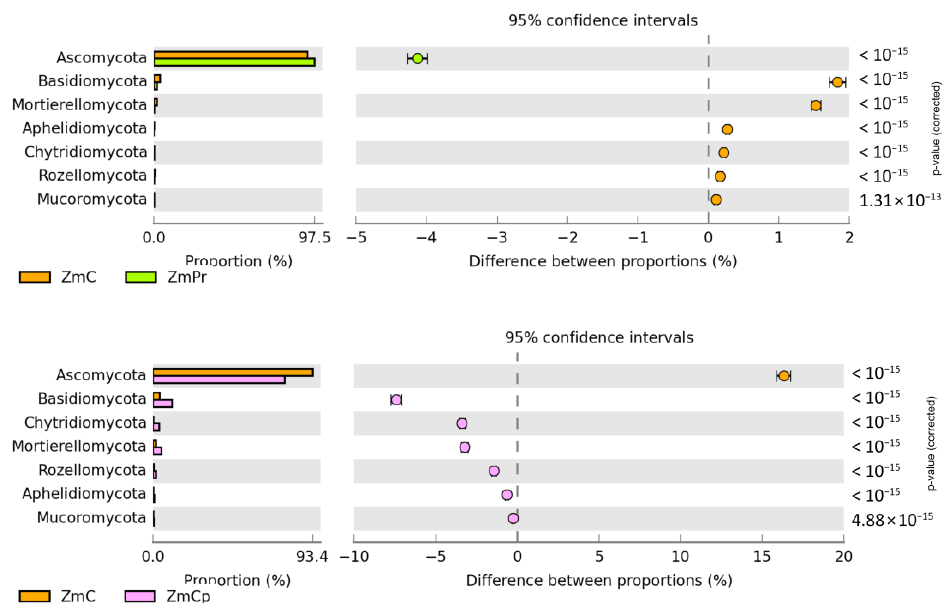
Figure 9. Relative abundance of dominant phylum fungi in the soil. uC — contaminated unsown soil; uPr — sown soil contaminated with permethrin; uCp — sown soil contaminated with cypermethrin; ZmC — uncontaminated soil sown with Zea mays ; ZmPr — soil sown with Zea mays contaminated